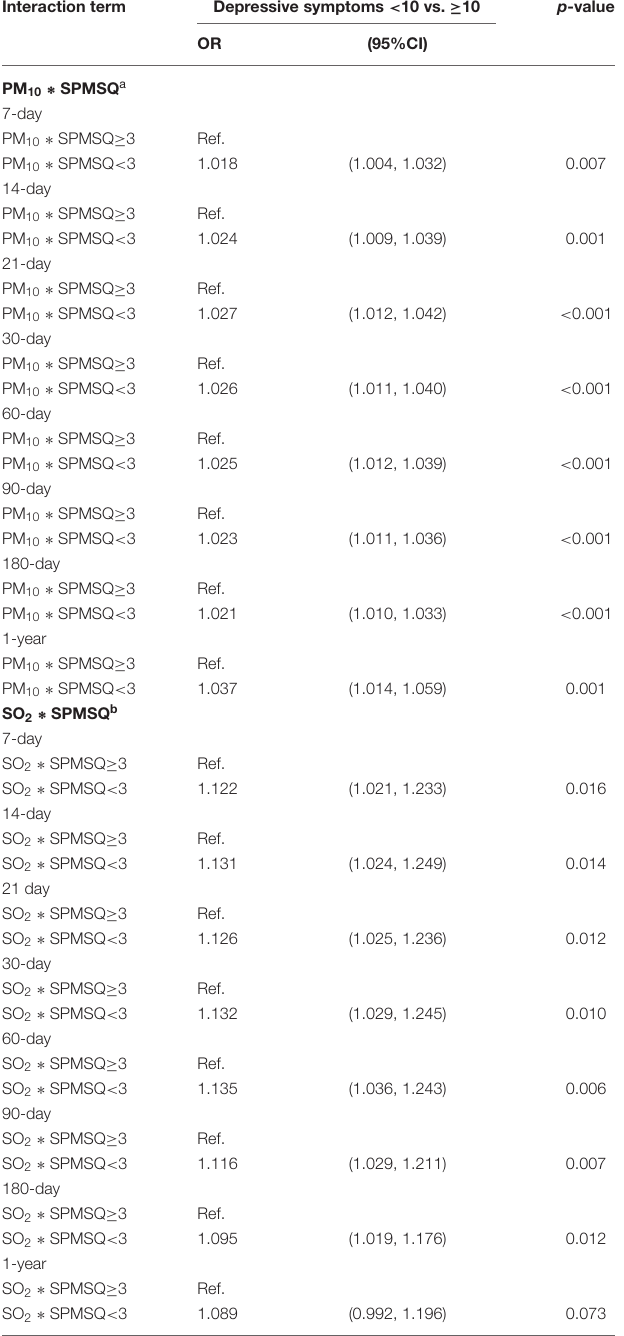
TABLE 3 | Association of interaction of air pollution (selected air pollutants) and cognitive function with depressive symptoms. Interaction term Depressive symptoms < 10 vs. ≥